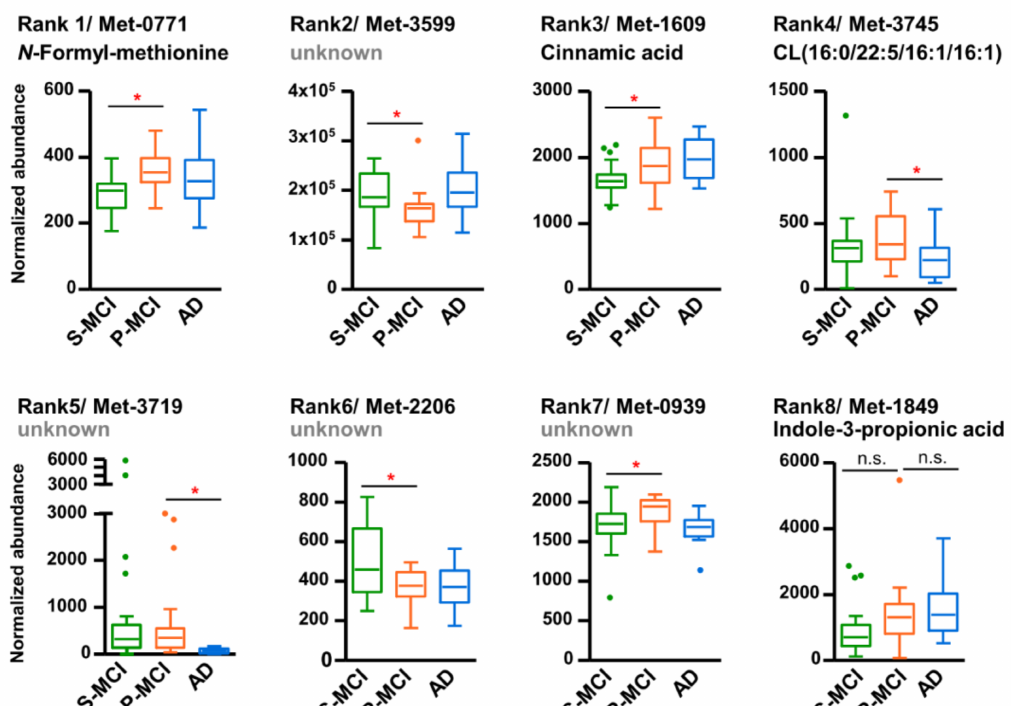
Figure 5. Box and whisker plots of eight representative features for differentiating the S-MCI, P-MCI, and AD groups. The box defines the 25th and 75th percentile of the intensity distribution and the horizontal line within the box representing the 50th percentile (median). Outliers are defined as having an intensity exceeding 1.5 interquartile ranges lower than 25th percentile or higher than the 75th percentile, which were indicated as dots. * p < 0.05. S-MCI, stable MCI; P-MCI, MCI proceeding to AD; CL, cardiolipin; n.s.,